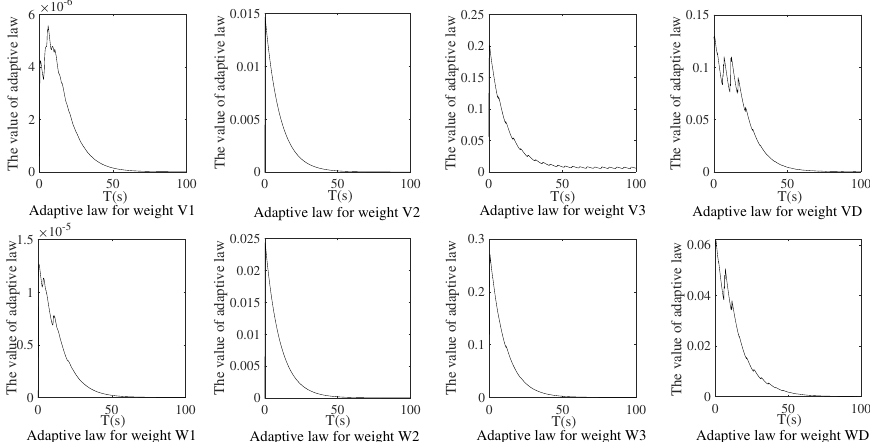
Figure 11. Adaptive compensation laws in unknown time-varying delay form (with dead-zone compensation